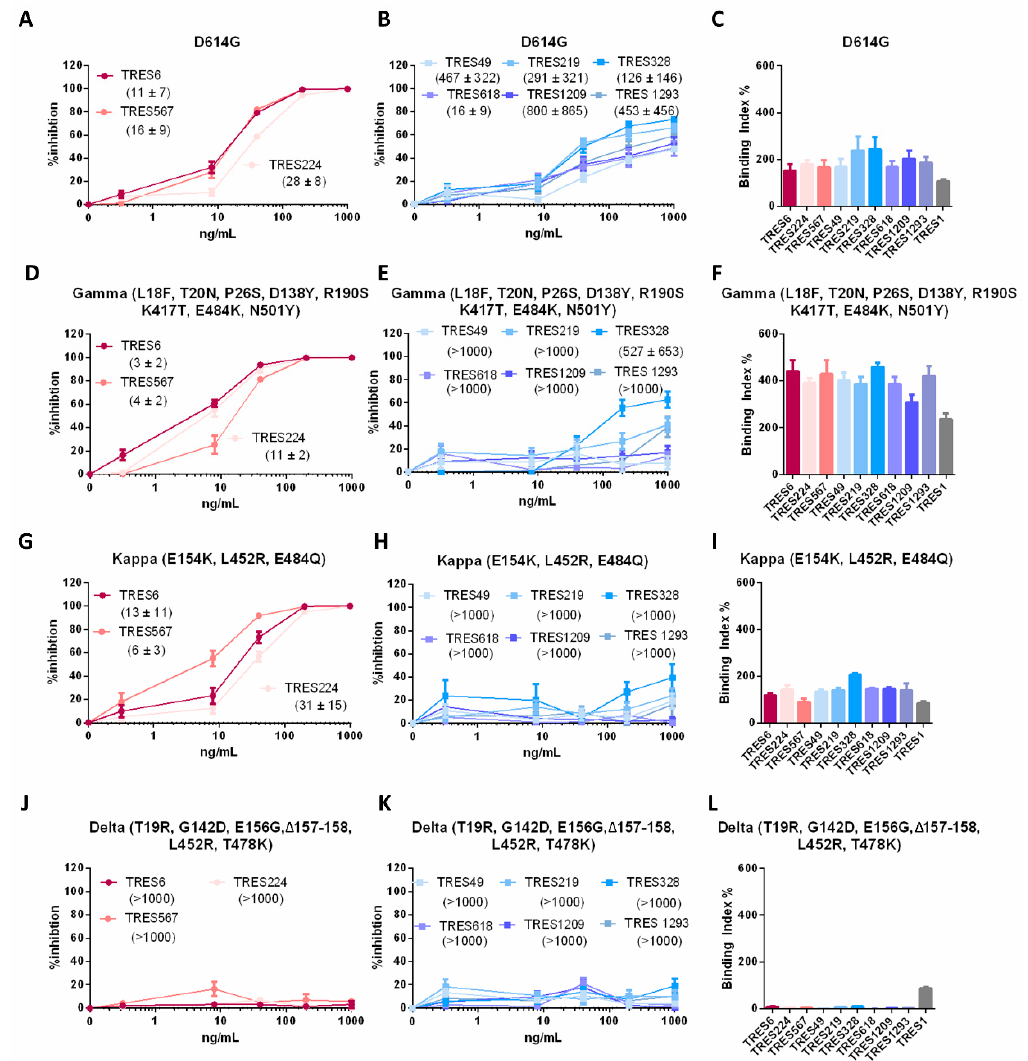
Figure 5. Characterization of SARS-CoV-2 S of the indicated VOCs. ( A , B , D , E , G , H , J , K ) Percent inhibition of lentiviral vector particles pseudotyped with S of the indicated VOCs. The relevant mutations within the NTD and RBD of the respective mutation are given in brackets. IC50s of the indicated RBD (red) and NTD (blue) cluster antibodies are shown in ng/mL in the brackets. ( C , F , I , L ) Binding of the RBD (red) and NTD (blue) cluster antibodies and an S2-binding antibody (grey) to S of the VOCs